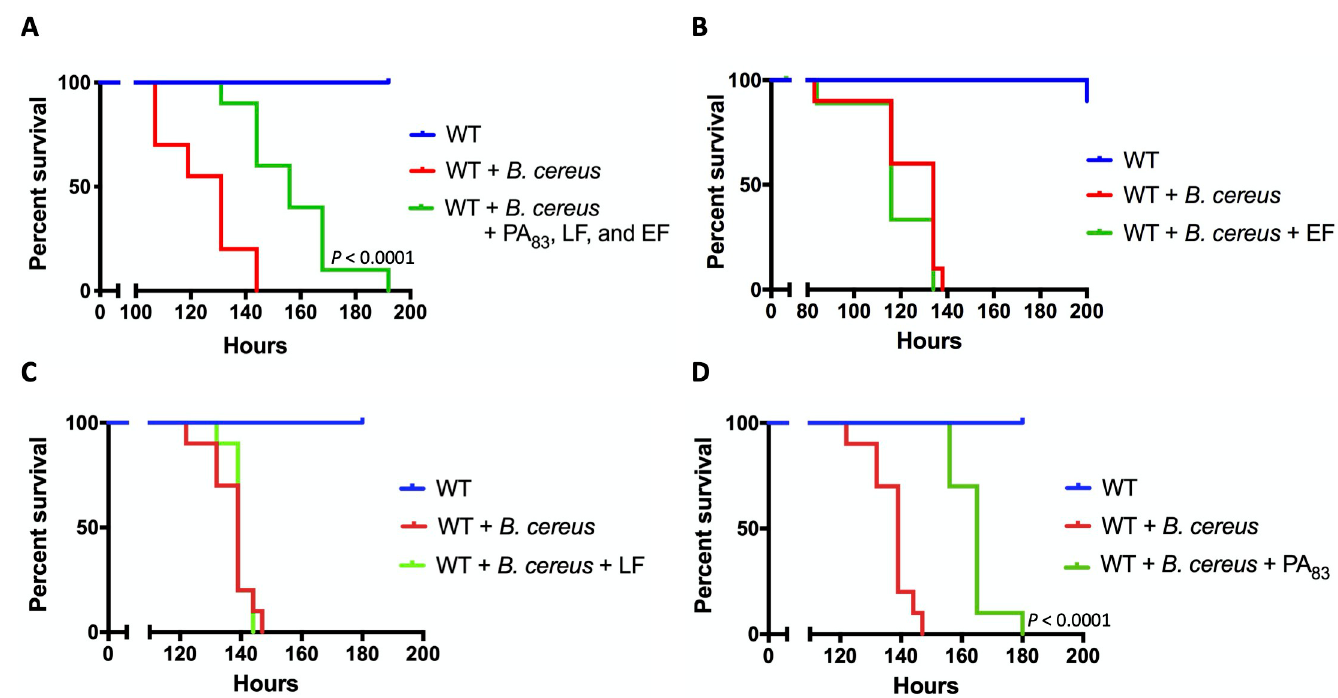
Fig 1. Anthrax toxin component PA 83 protects Drosophila from Bacillus cereus . The discovery of PA-mediated reduction in sensitivity of flies to B . cereus infection. Male Oregon-R wild type (WT) flies were challenged with B . cereus in the absence or presence of one or more anthrax toxin components, including a combination of all toxin components (A), EF (B), LF (C), and PA 83 (D). P values indicate statistical significance compared to the bacteria-only condition.